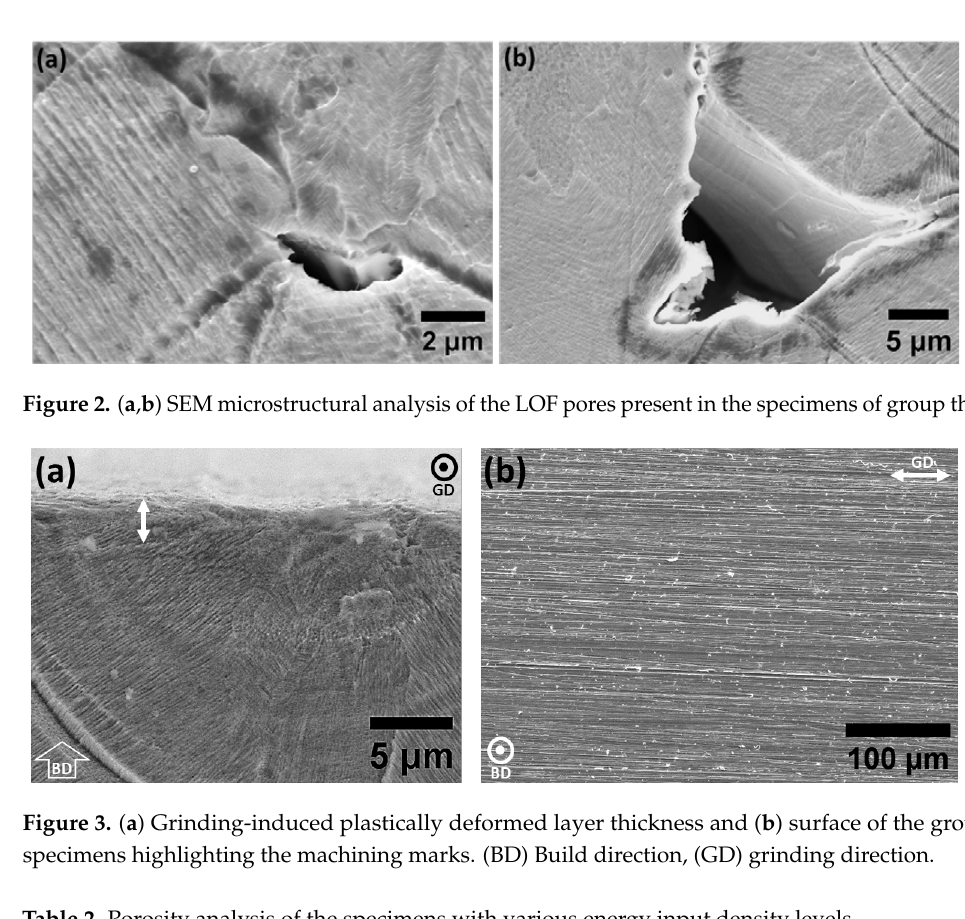
Figure 1. Optical and SEM microstructural analysis of L-PBF specimens of ( a , d ) group one, ( b , e ) group two, and ( c , f ) group three.